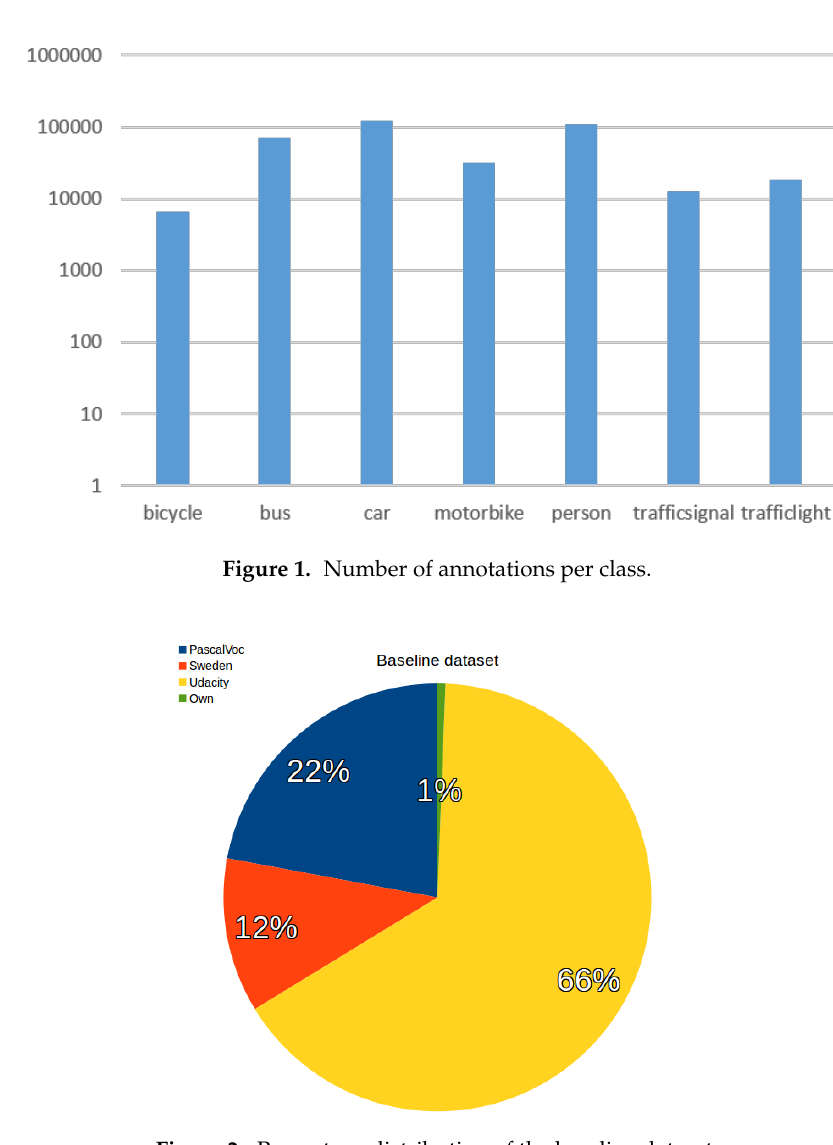
Figure 2. Percentage distribution of the baseline dataset. Table 1. All mAPs per individual class across all